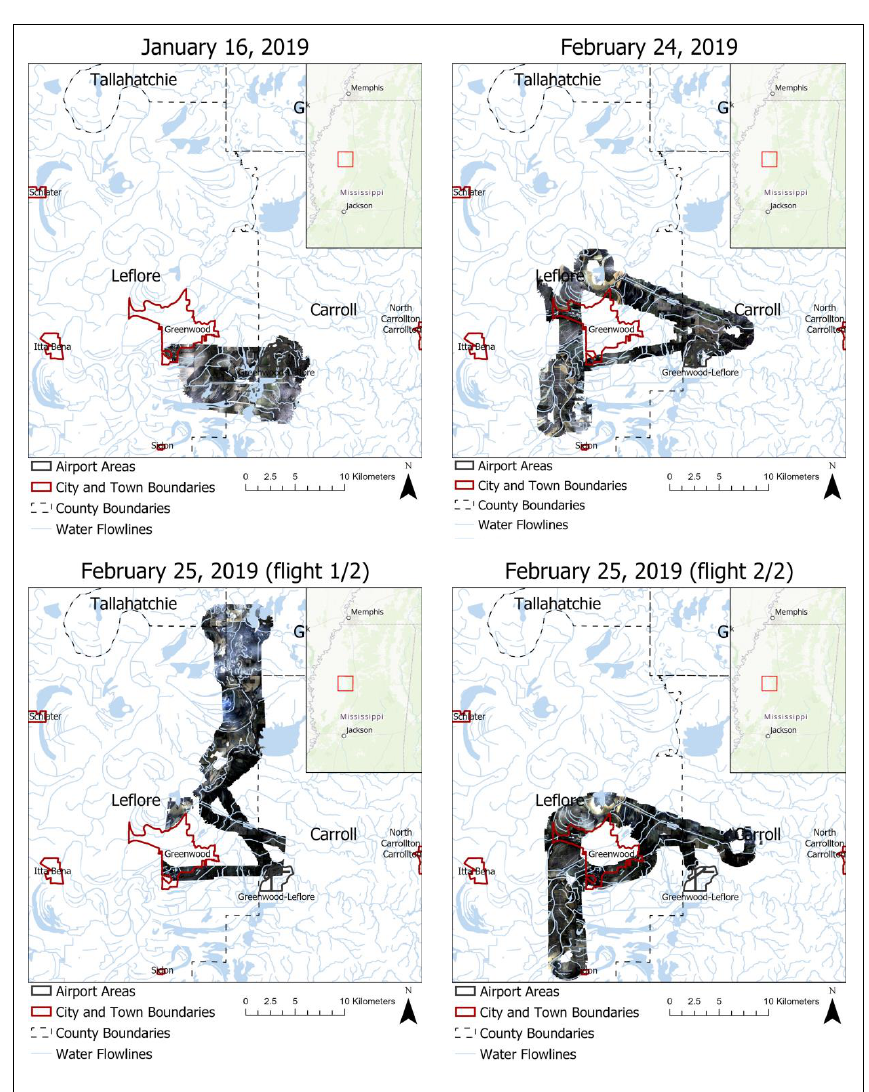
Figure 3. Extent of Unmanned Aerial Systems (UAS) imagery during the SHOUT4Rivers Phase 2 flights over Greenwood, MS.